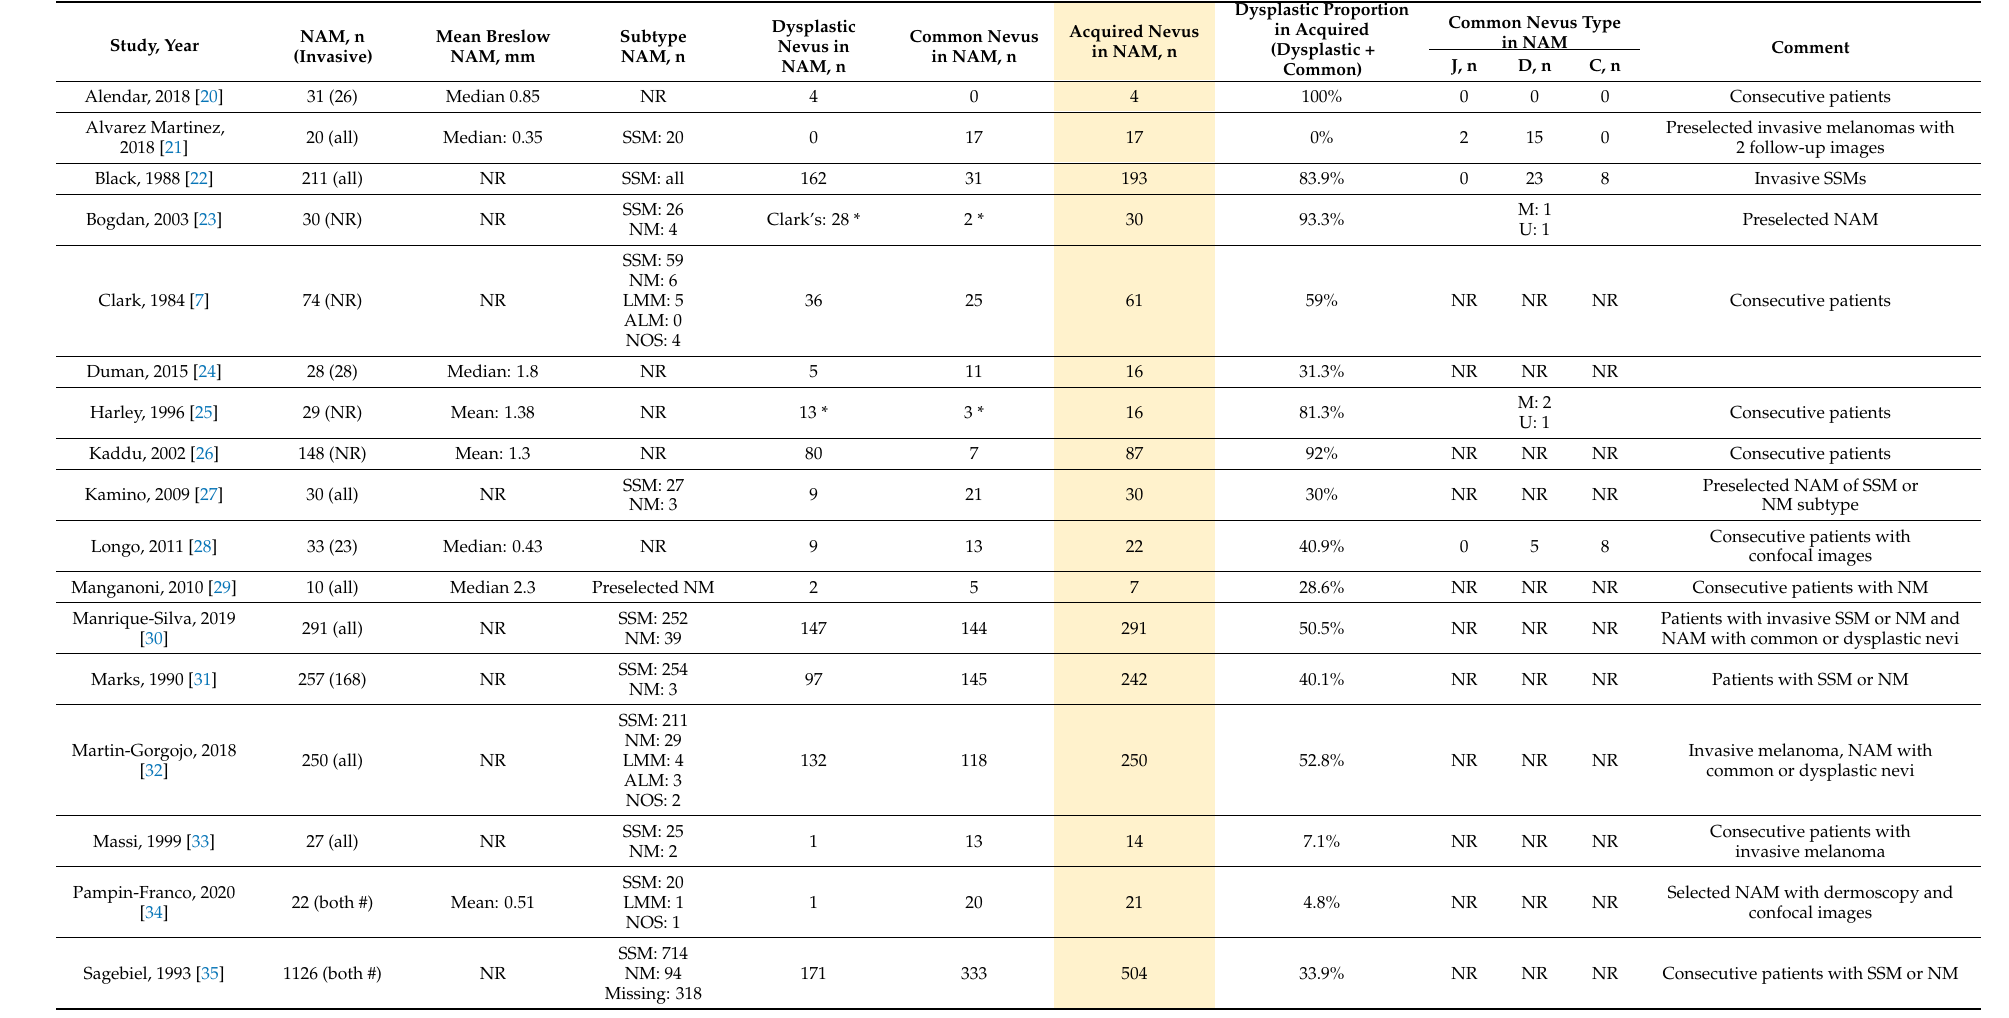
Table 1. Included studies reporting the type of acquired melanocytic nevus in histological association with cutaneous melanoma ( n =